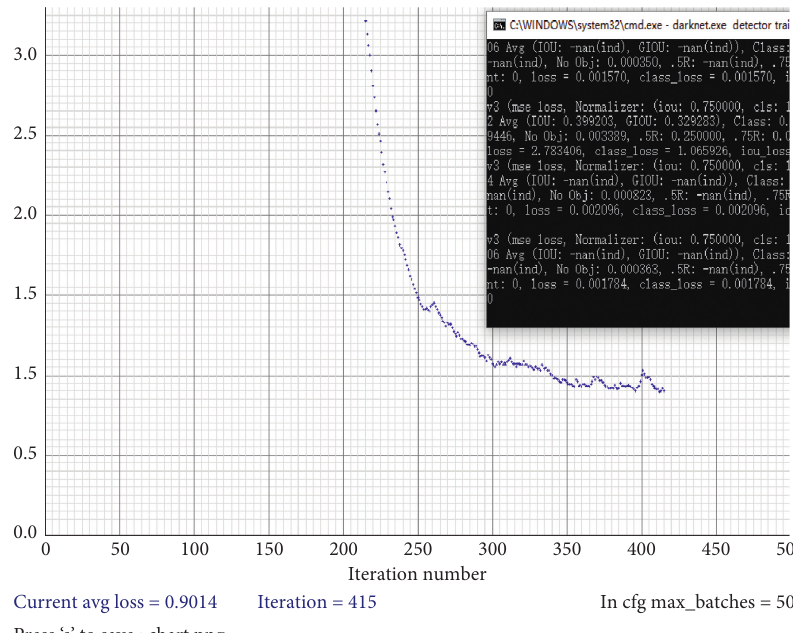
Figure 4: Current average loss convergence graph.